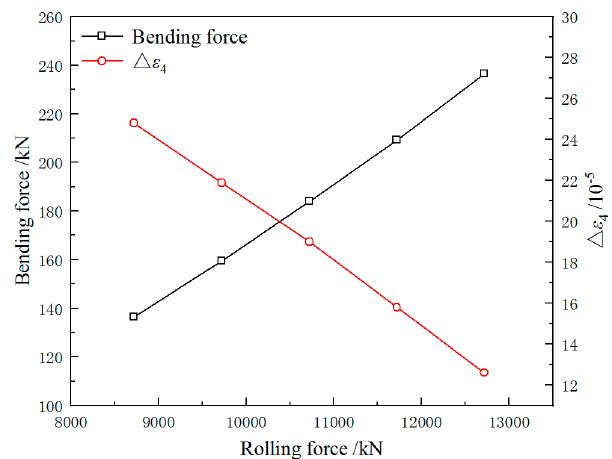
Figure 16. The Δ ε 4 of the strip with different rolling forces. Figure 16. The ∆ ε 4 of the strip with di ff erent rolling forces. Metals 2020 , 10 , x FOR PEER REVIEW